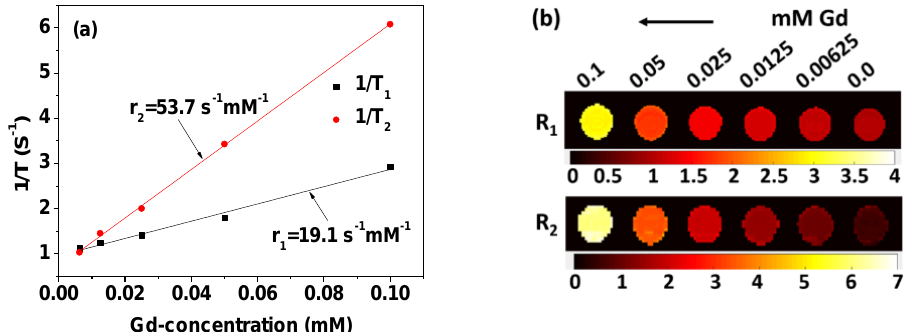
Figure 8. ( a ) Plots of 1/T 1 and 1/T 2 versus Gd-concentration (slopes are r 1 and r 2 values, respectively). ( b ) Dose-dependent R 1 and R 2 map images showing contrast changes with Gd-concentration.